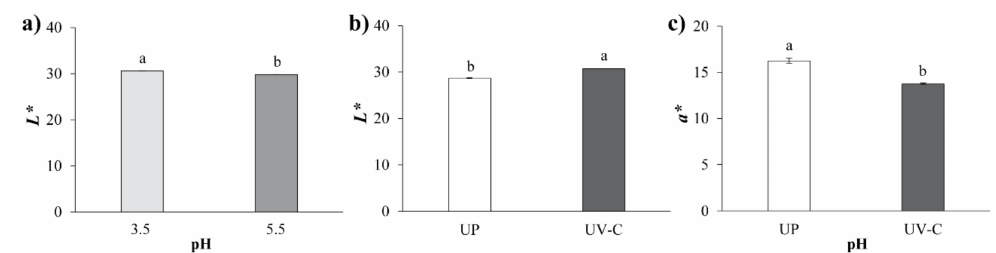
Figure 1. E ff ects on color parameters of Aloe vera –pitaya blends subjected to UV-C treatments and di ff erent pH values ( a ) E ff ect of pH on L * parameter. ( b ) E ff ect on the L * parameter of UV-C treatments compared to UP (unprocessed) treatments. ( c ) E ff ect on the a * parameter of UV-C treatments compared to UP (unprocessed) treatments. For each figure panel, the di ff erent letters indicate significant di ff erences between the treatments at p <